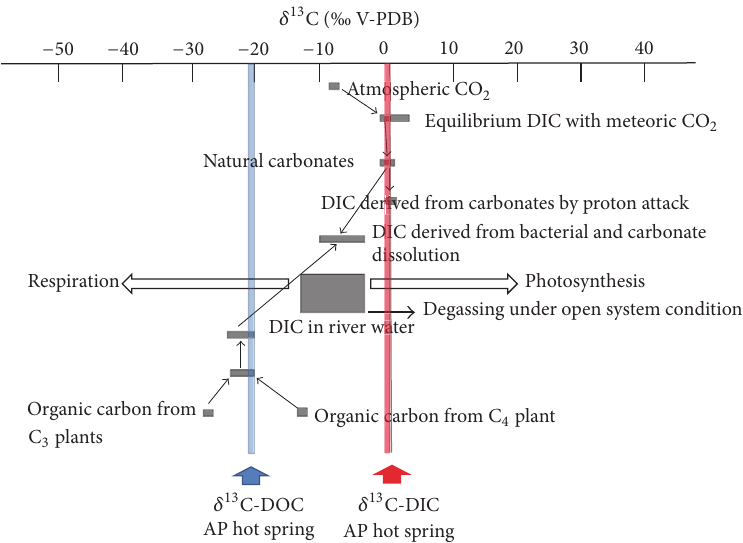
Figure 9: The 𝛿 13 C-DIC and 𝛿 13 C-DOC in AP hot